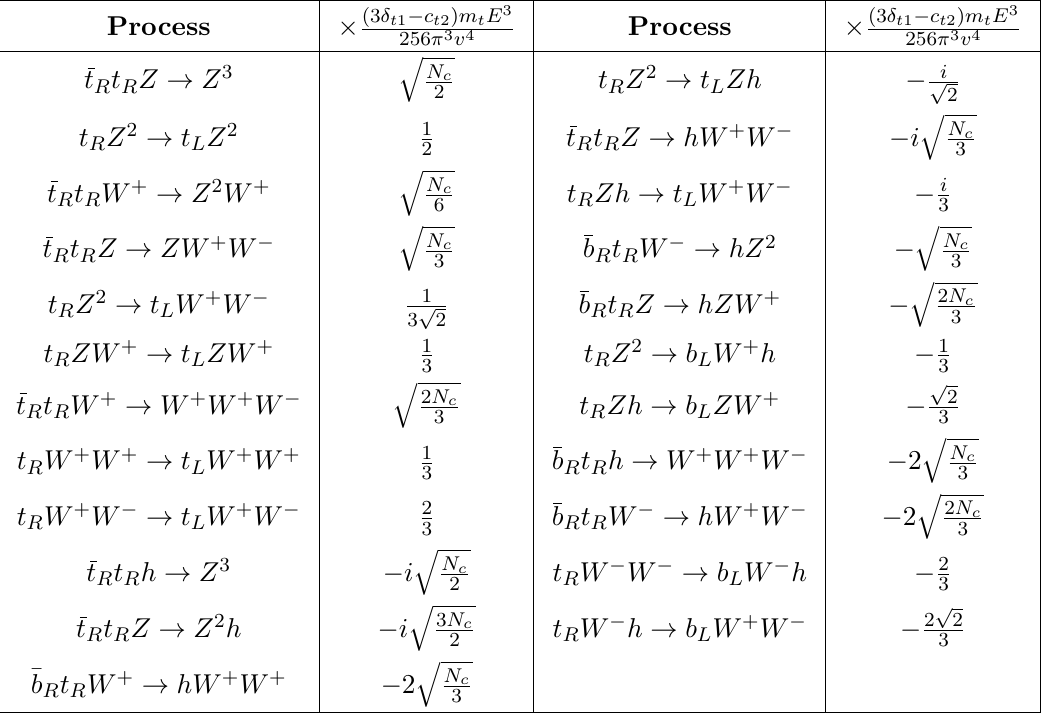
Table 9 . 6-body unitarity-violating processes that depend on c t 2 and δ t 1 . One can see that the dim-6 SMEFT prediction c = 3 δ gives vanishing amplitudes for all t 2 t 1